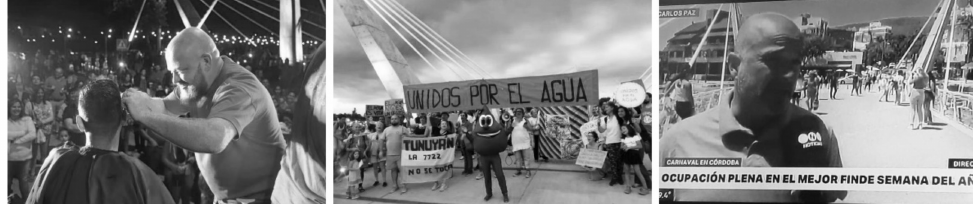
Figure 18. The project as a democratic venue: ( left ) Hairdressers’ marathon (charity event). ( center ) Public protest on water management. ( right ) T.V. interviews using the bridge as a referential place. (Credit: Left and Center: reproduced with permission from the author, Mr. Mario Rojas; Right: Still from public television broadcast (Cordoba